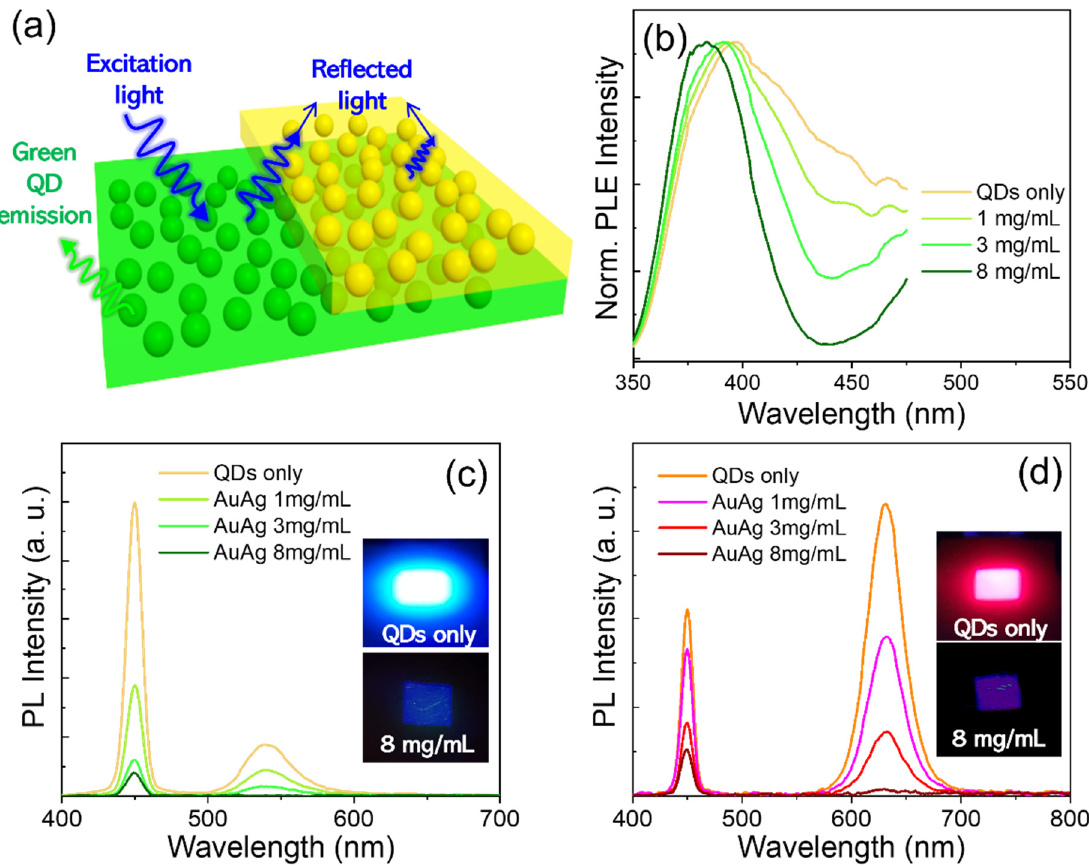
Figure 5. ( a ) Schematic showing AuAg NP polymeric film blocking ambient excitation lights, thus preventing undesired QD excitation. ( b ) Normalized PLE spectra of green QD-PDMS film/AuAg NP-PMMA film stack with different AuAg NP concentrations, measured with excitation lights directed onto the AuAg NP film side. PL spectra of ( c ) green and ( d ) red QD-PDMS film/AuAg NP-PMMA film stack having different AuAg NP concentrations, measured with an excitation of 450 nm directed on AuAg NP film side.